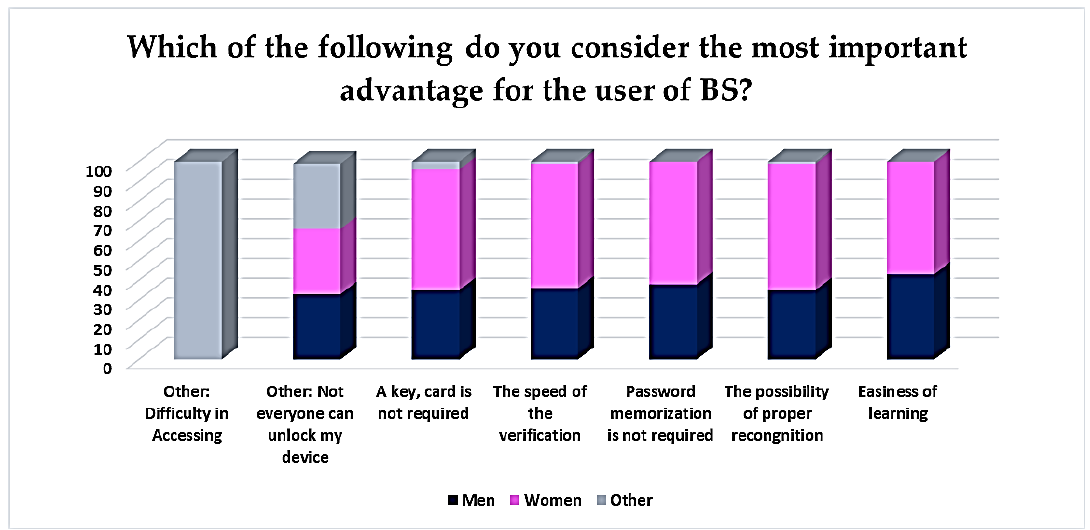
Figure 10. BS advantages per gender.